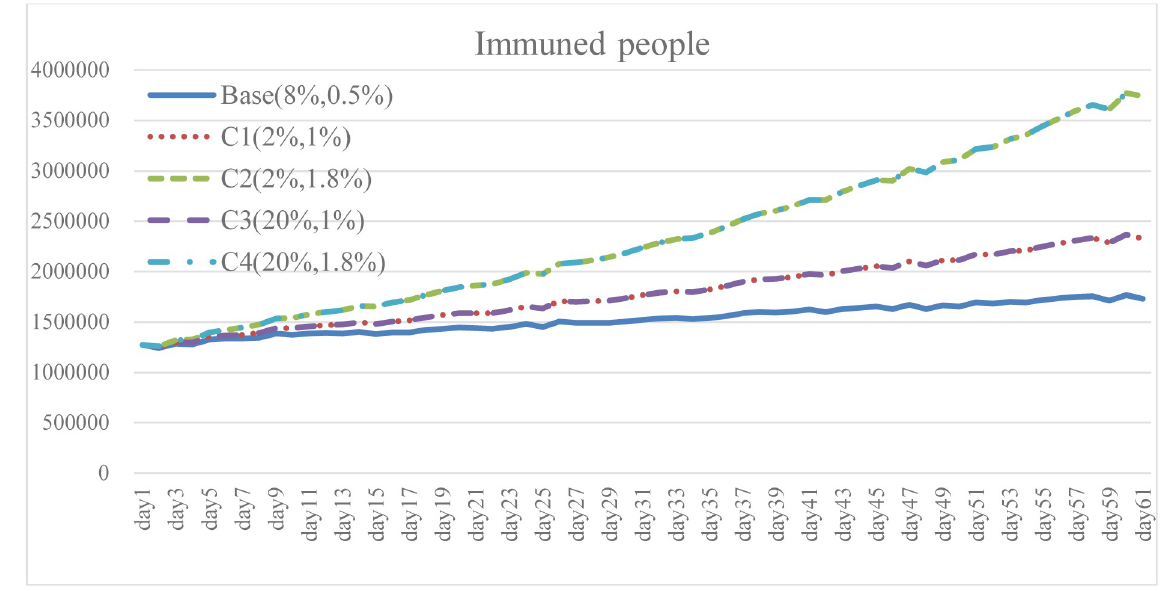
Fig 19. Immuned people under different isolation percentage and vaccine